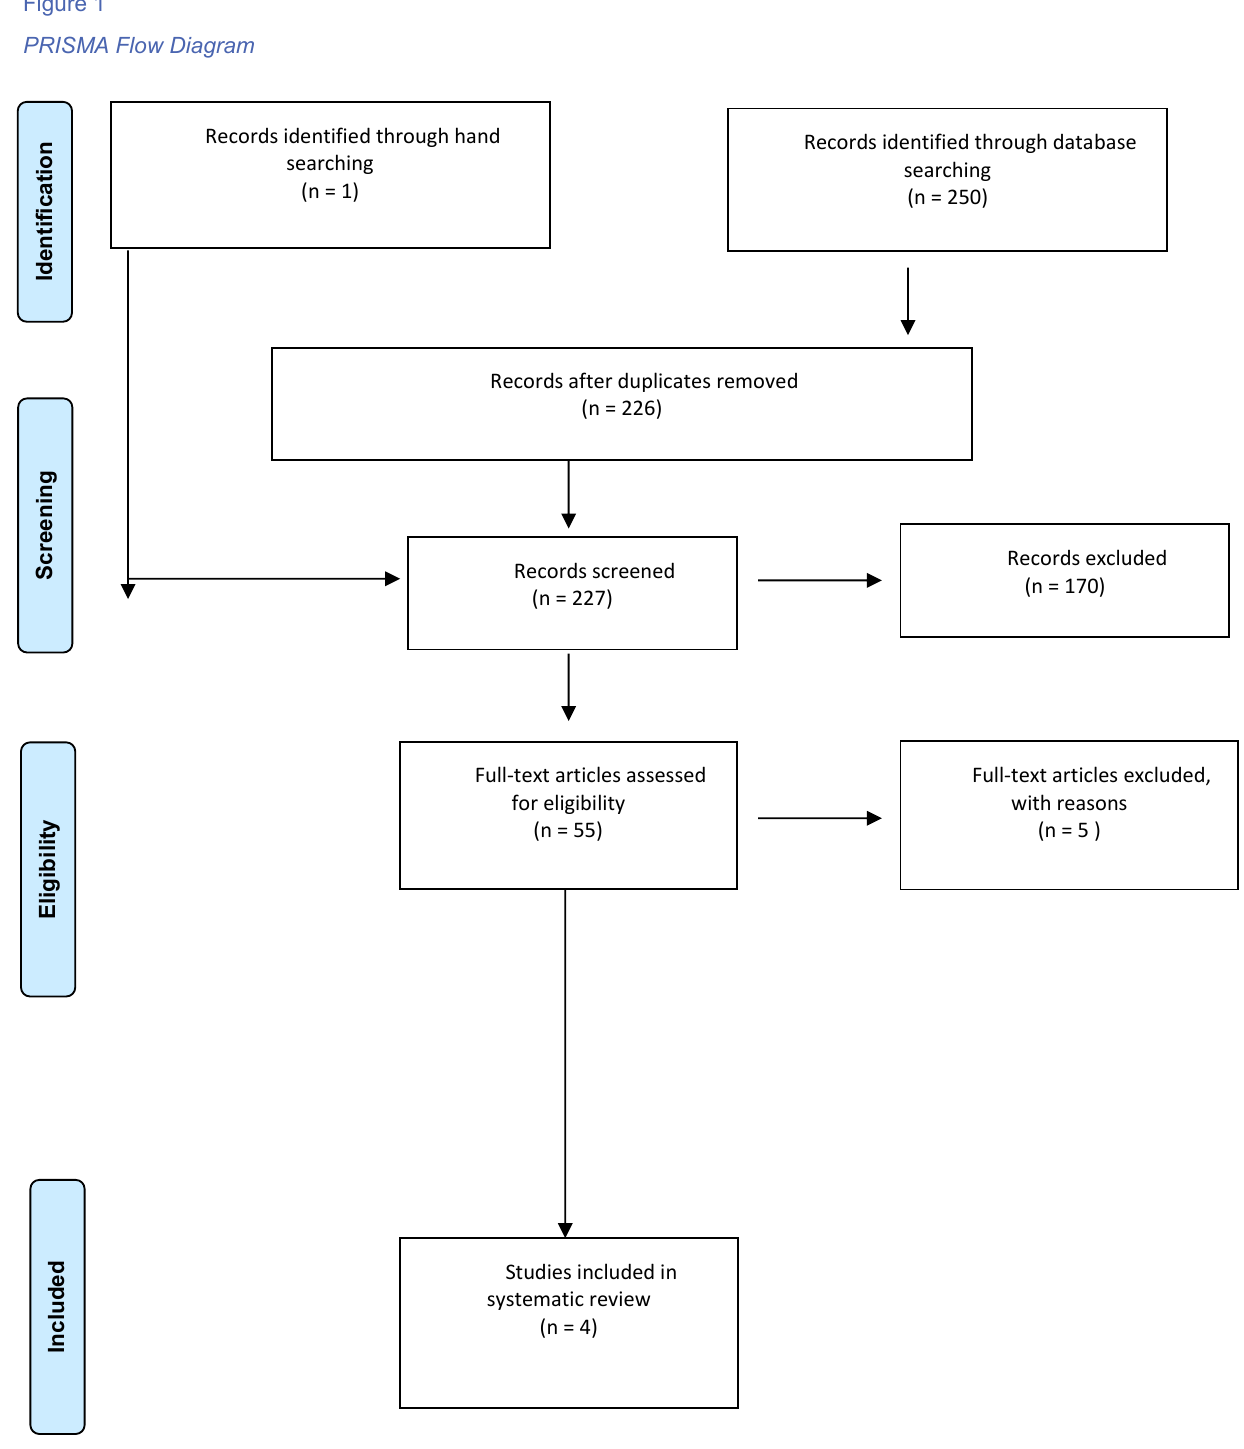
Figure 1 PRISMA Flow Diagram